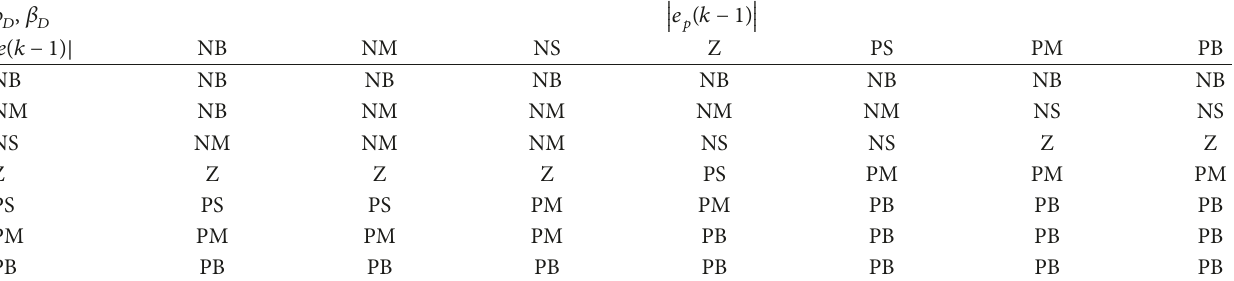
Table 5: The fuzzy rules of 𝜌 𝐷 , 𝛽 𝐷 .